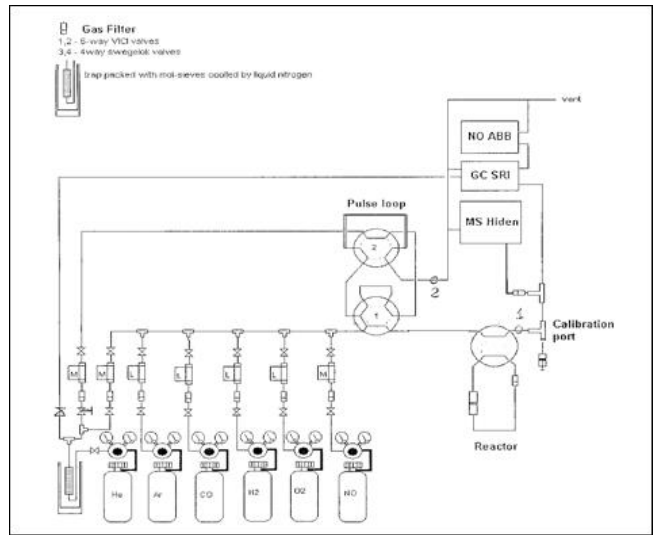
Figure 11. Schematic flow diagram of the reaction system.